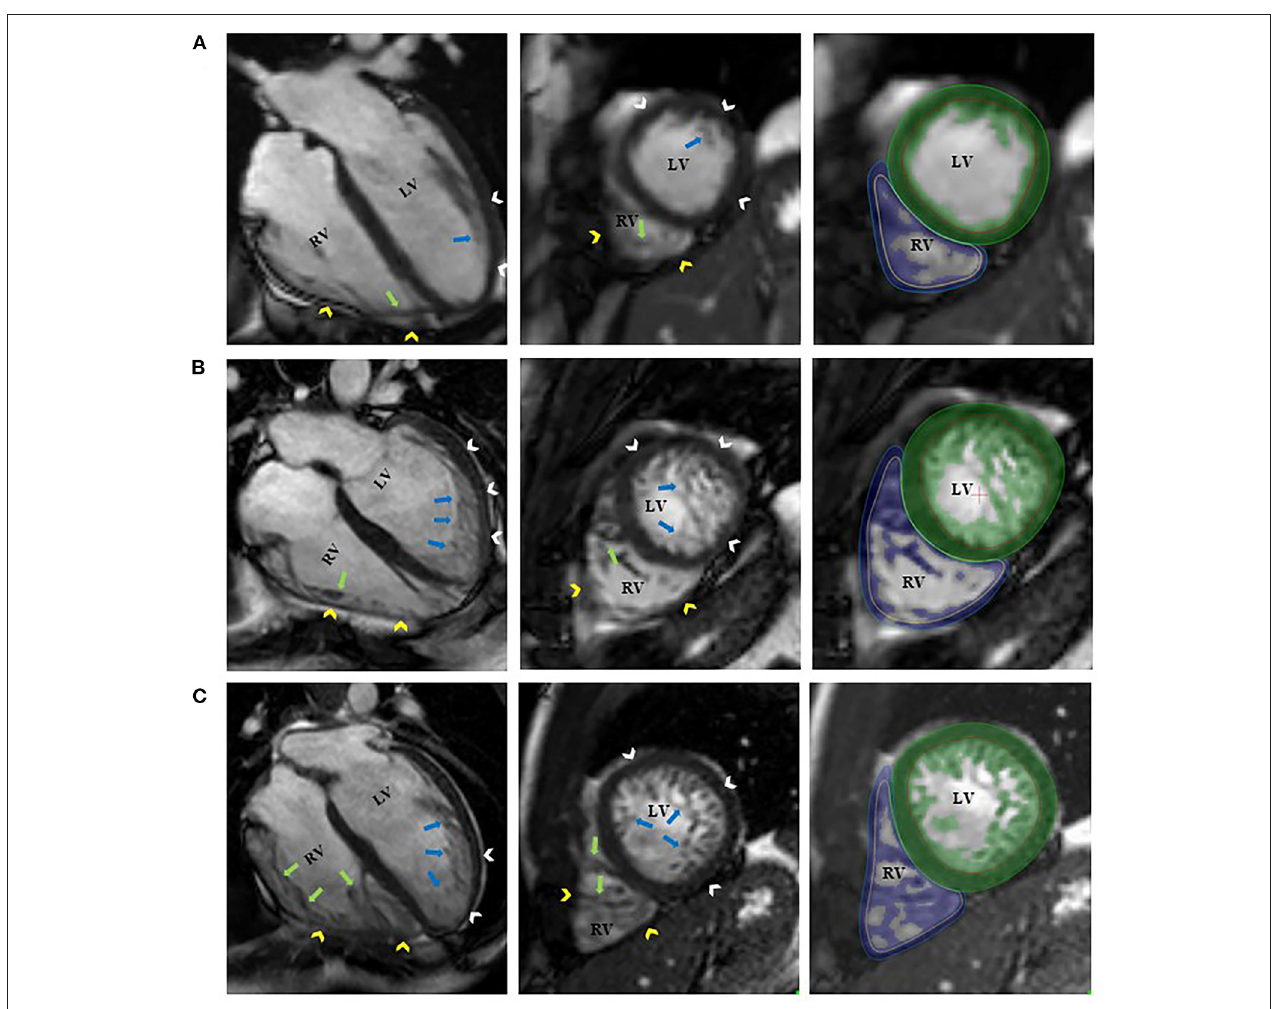
FIGURE 1 | Representative 4-chamber long-axis and short-axis images of a control participant [ (A) , RV-TMi = 12.6 g/m 2 , age and sex-specific reference: 13.9 (11.9, 19.3) g/m 2 ]; a patient with left ventricular non-compaction phenotype and normal amount of right ventricular trabeculation [ (B) , RV-TMi = 25.2 g/m 2 , age and sex-specific reference: 21.8 ± 5.2 g/m 2 ]; and a patient with left ventricular non-compaction phenotype and right ventricular hypertrabeculation [ (C) , RV-TMi = 32.9 g/m 2 , age and sex-specific reference: 19.9 ± 3.7 g/m 2 ]. The white and yellow arrowheads represent the left and right ventricular compacted myocardium. The blue and green arrows represent the left and right ventricular endocardial trabeculation. The green and blue areas represent the myocardial mass, including the endocardial trabeculation of the left and right ventricles, respectively. LV, left ventricle; LVNC, left ventricular non-compaction; RV, right ventricle; RV-TMi, right ventricular trabeculated myocardial mass